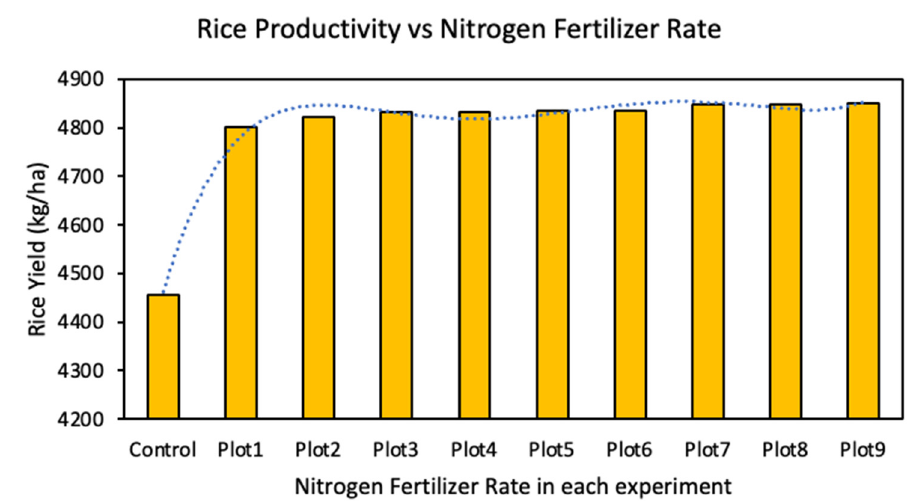
Figure 6. Normal distribution of nitrogen fertilizer rate on rice yield production in north- ern Thailand.